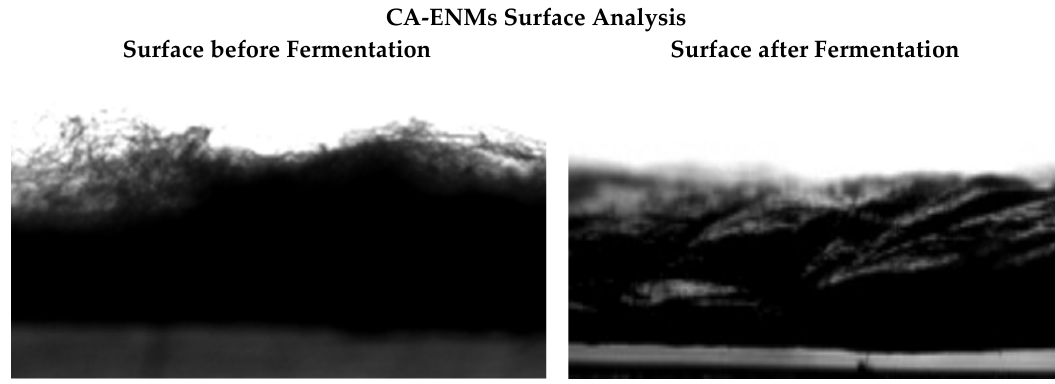
Figure 4. Photographs of CA-ENM surfaces before fermentation ( left ) and after seven days of fermentation ( right ).